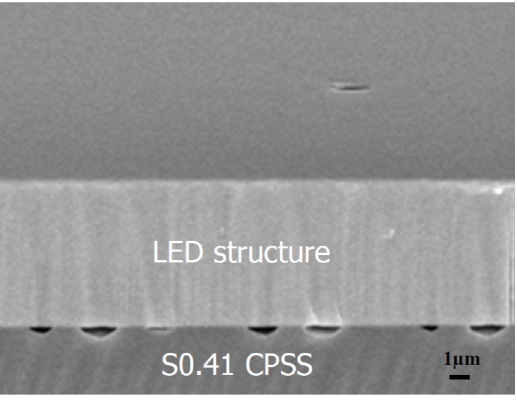
Figure 2. Cross-sectional SEM image of S0.41-GaN with voids between light-emitting diode (LED) and CPSS.